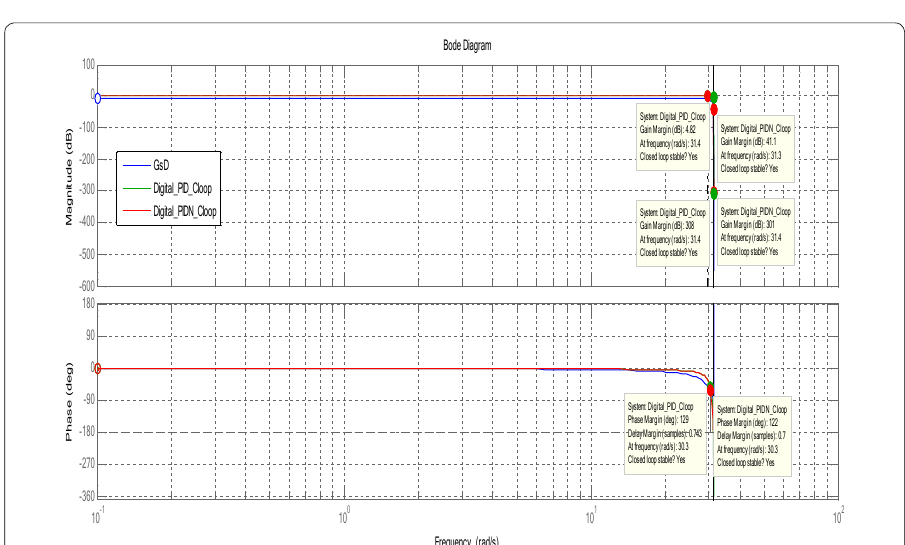
Fig. 14 Digital domain-frequency response of BBC with PID and PIDN and without PID control in buck